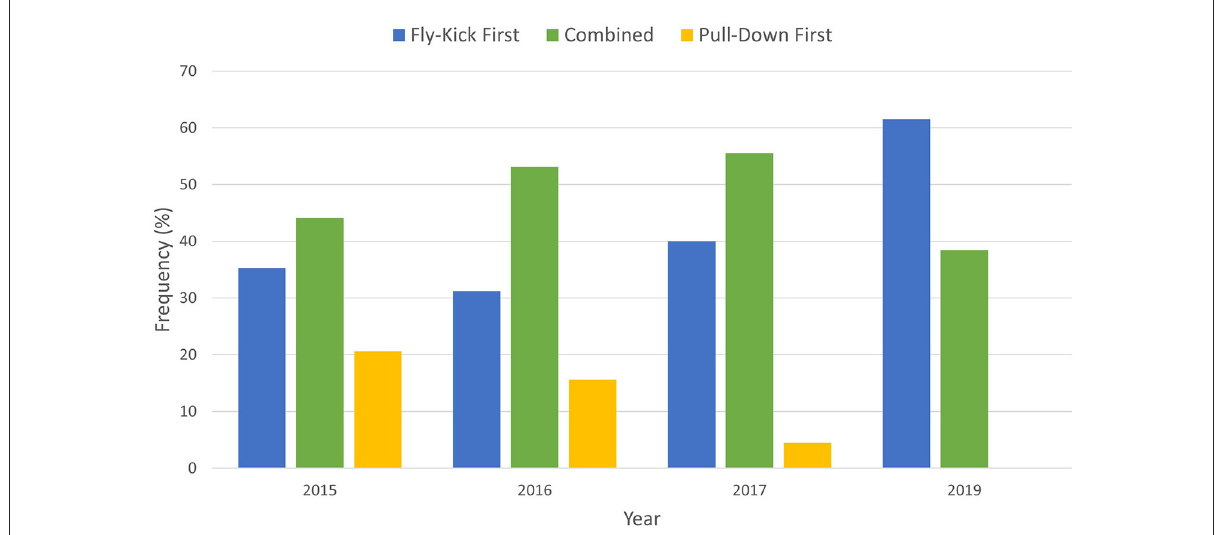
FIGURE4 Underwater breaststroke pullout technique trends for elite swimmers during the period 2015–2019.